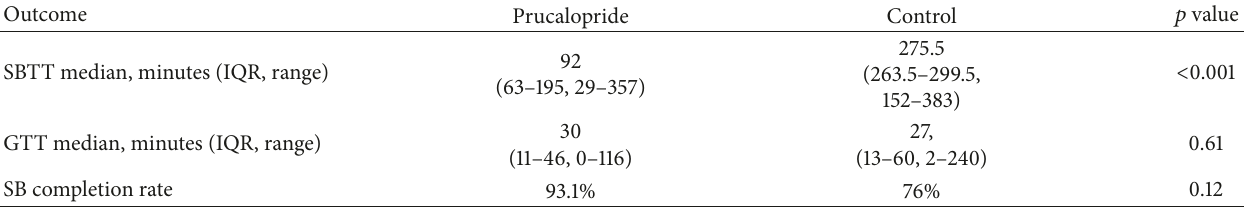
Table 2: Transit times and completion rates in the prucalopride versus the control